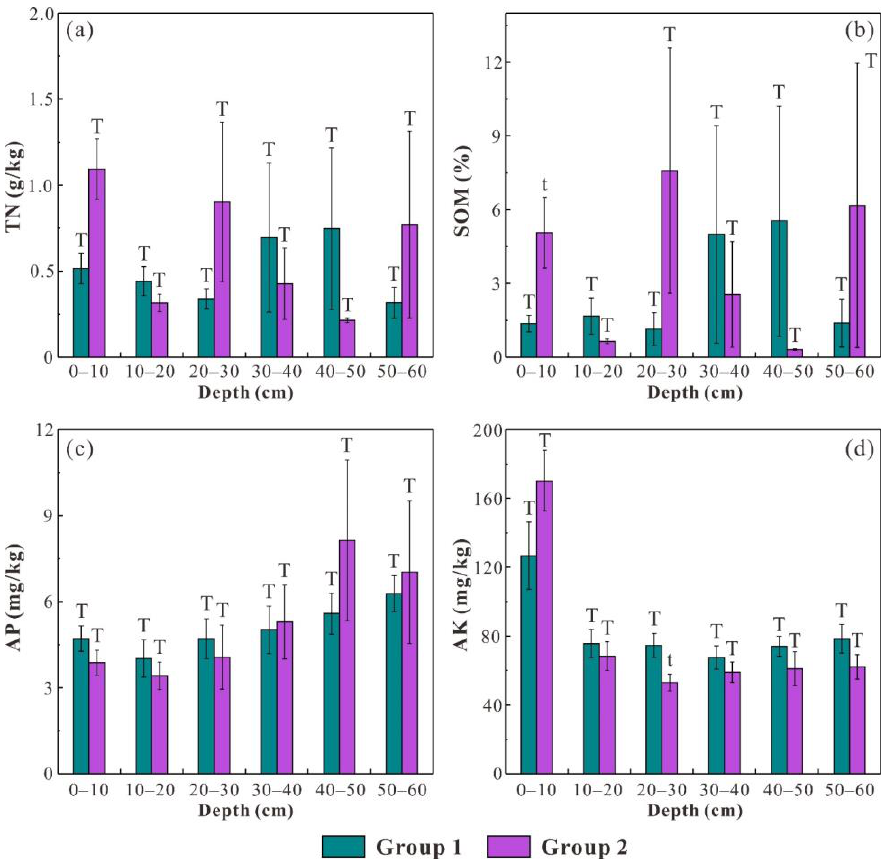
Figure 6. The average contents of TN ( a ), SOM ( b ), AP ( c ) and AK ( d ) in group 1 and group 2 (the classification of the two groups is based on the Ks values). The error bar represents the standard error and different forms of T denote significant difference.